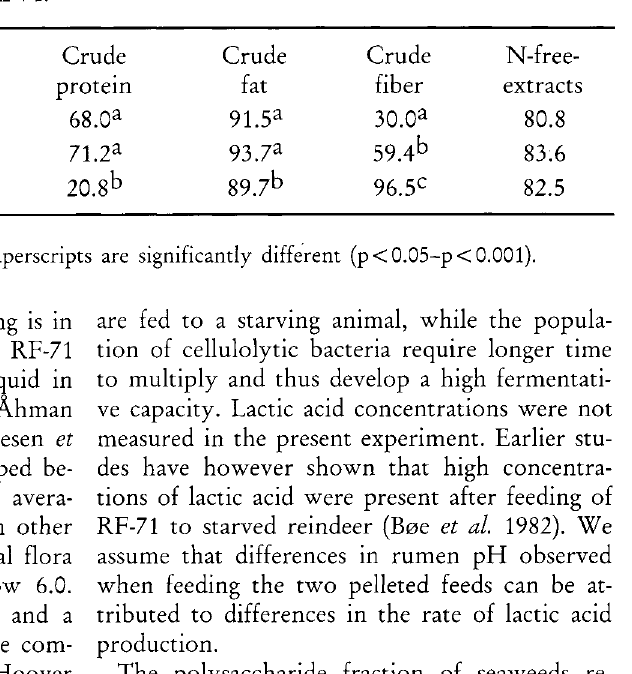
Table 4. Digestibility coefficients for the chemical components in the feeds used. Average of 4 animals for RF- 80 and lichen and two animals for RF-71.